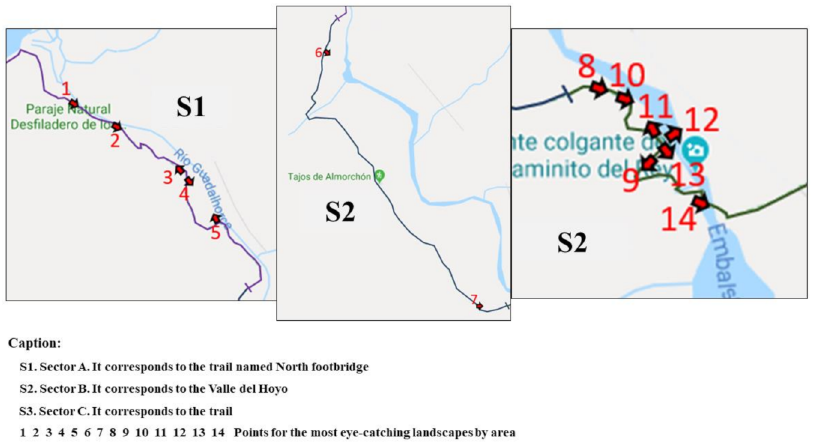
Figure 3. General location according to sector of all images analyzed through the eye-tracking device.